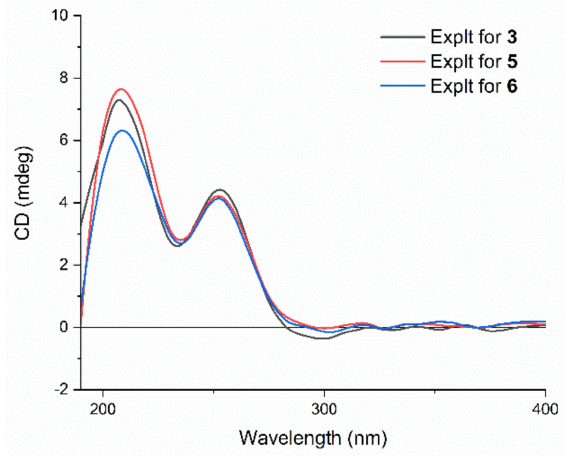
Figure 3. Experimental ECD spectra of compounds 3 , 5 , and 6